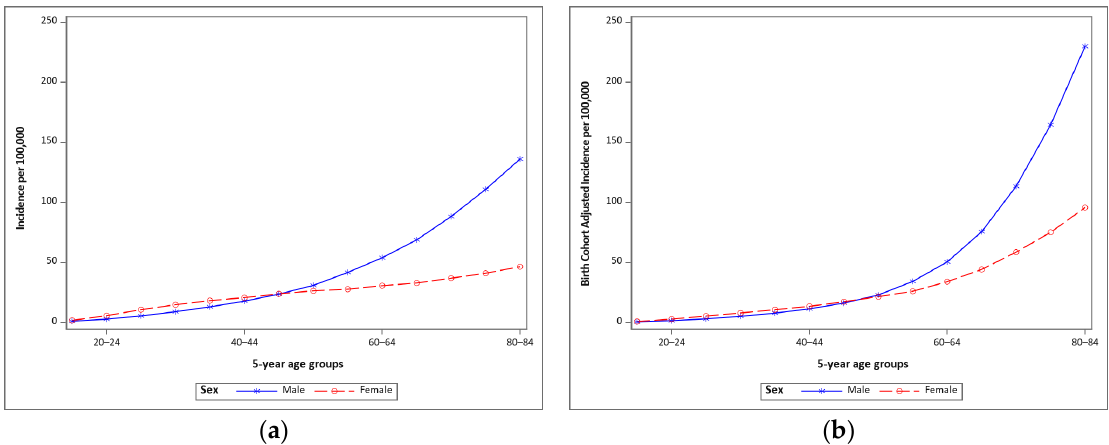
Figure 3. Incidence of malignant melanoma for 5-year age groups by sex, ( a ) crude, and ( b ) adjusted for 5-year birth cohort. Data from SEER 9, 1975–2017.